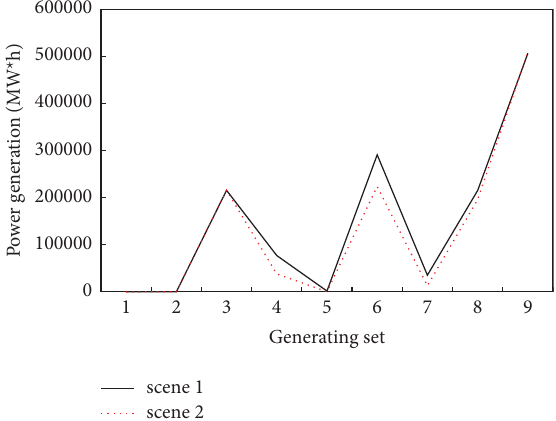
Figure 4: Changes in the expected electricity production of conventional units before and after simply adding a new energy power generation